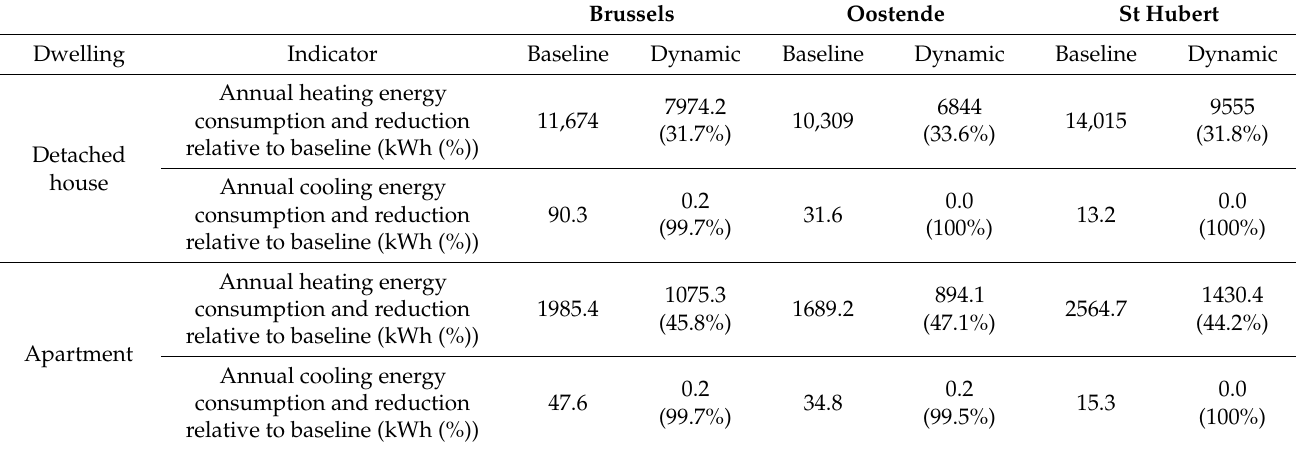
Table 10. Annual heating and cooling energy consumption for static and SIS walls and windows applied to two prototypical dwellings for three climates in